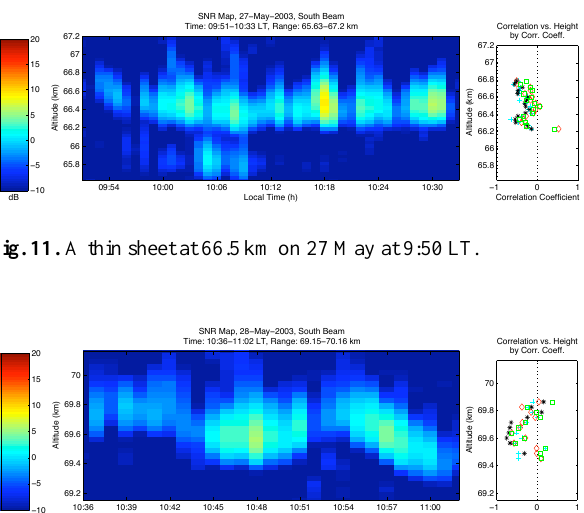
Fig. 11. A thin sheet at 66.5 km on May 27 at 9:50 LT.